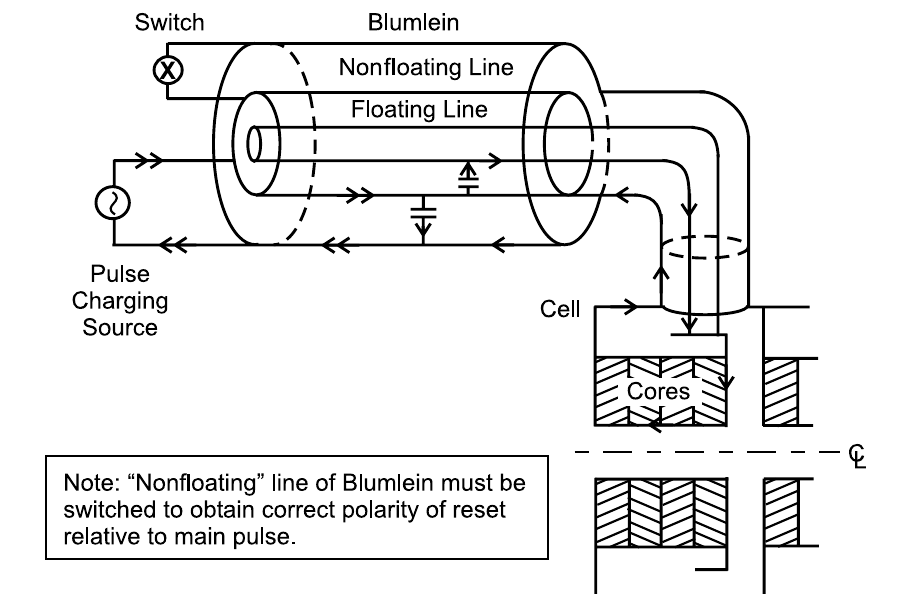
FIG. 28. Current charging the capacitance of the ‘‘floating’’ line of Blumlein (shown by arrows) can be used to reset cell